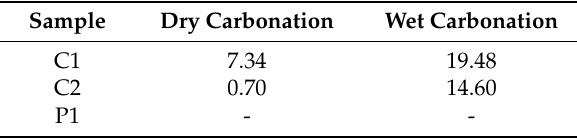
Table 4. Calculated amounts of CO 2 sequestrated by using XRD Rietveld refinement analysis (wt %).